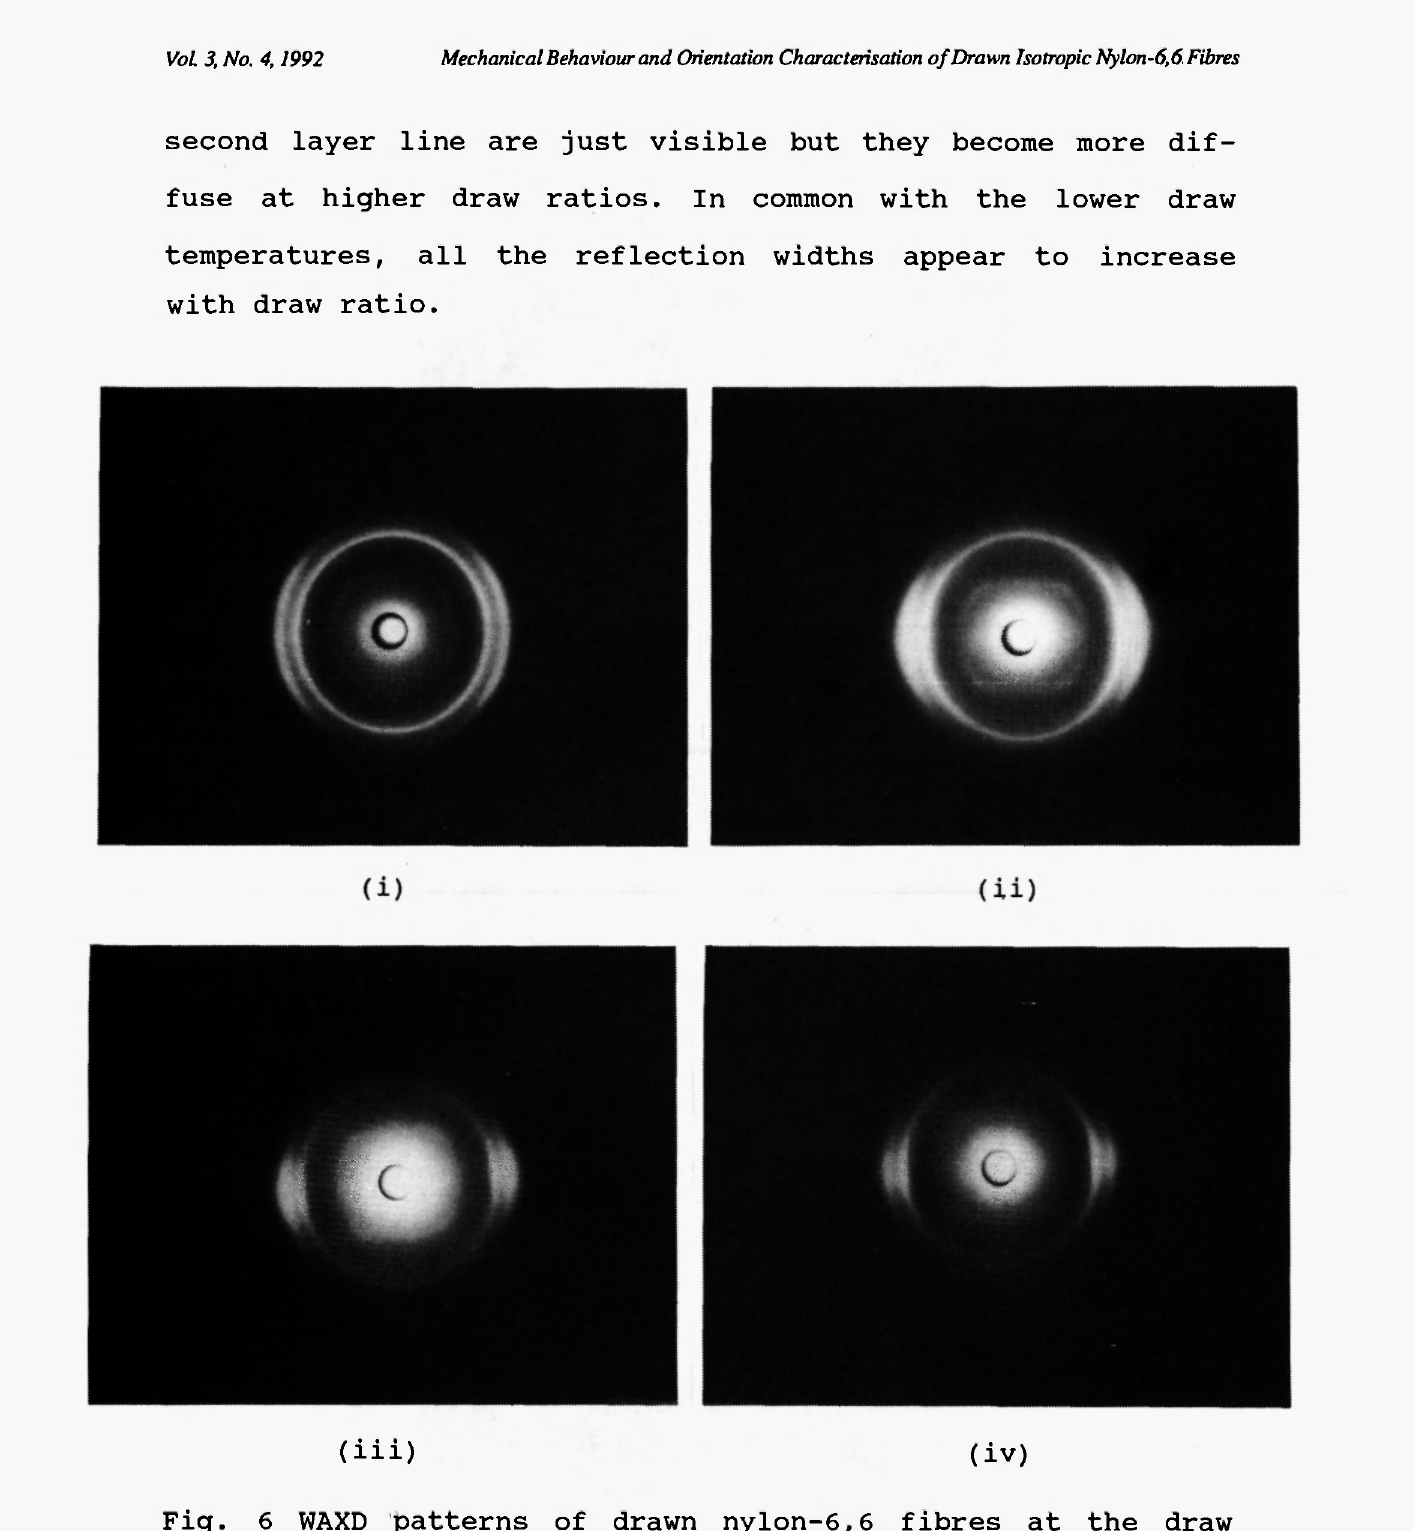
6 WAXD patterns of drawn nylon-6,6 fibres at the